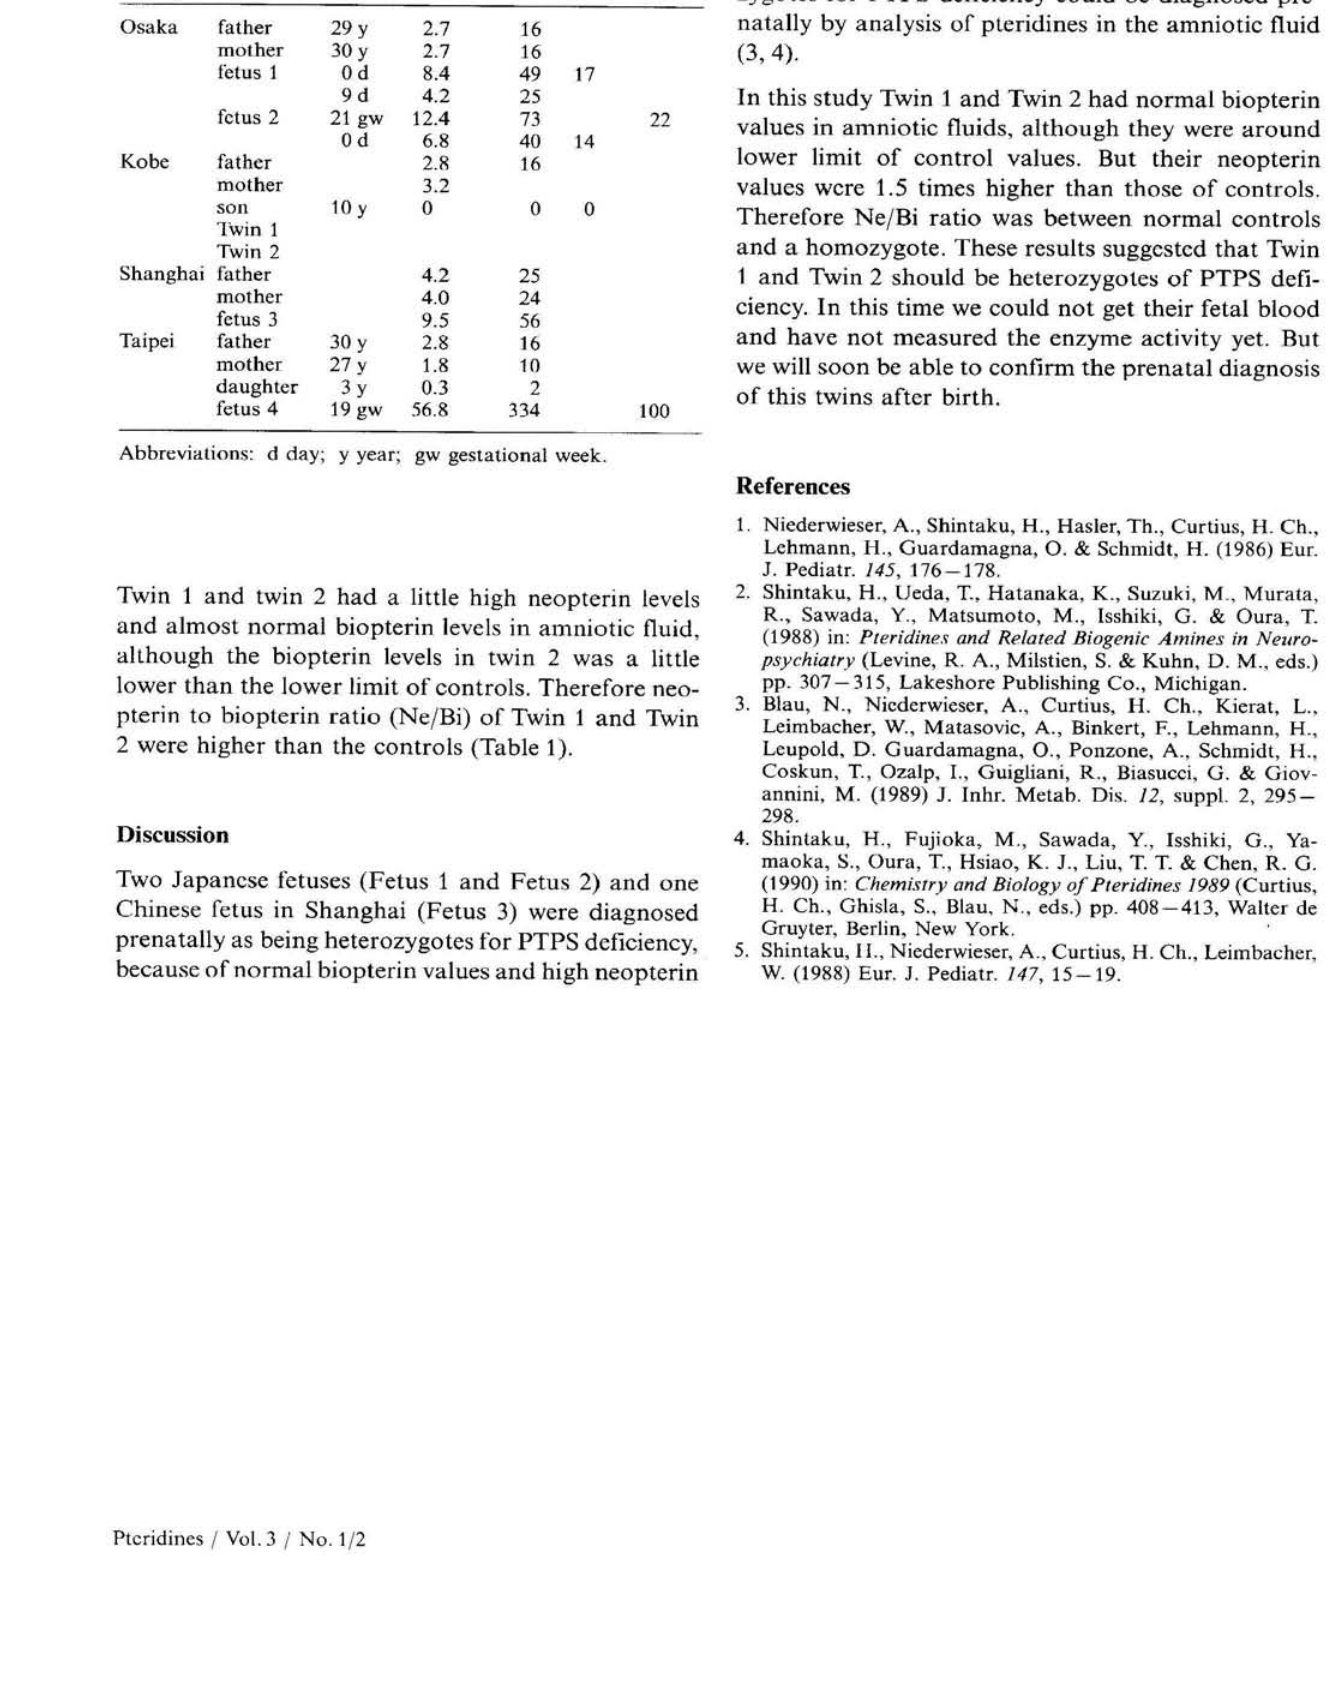
Table 2. PTPS activity in erythrocytes of the probands, and their families. City Family